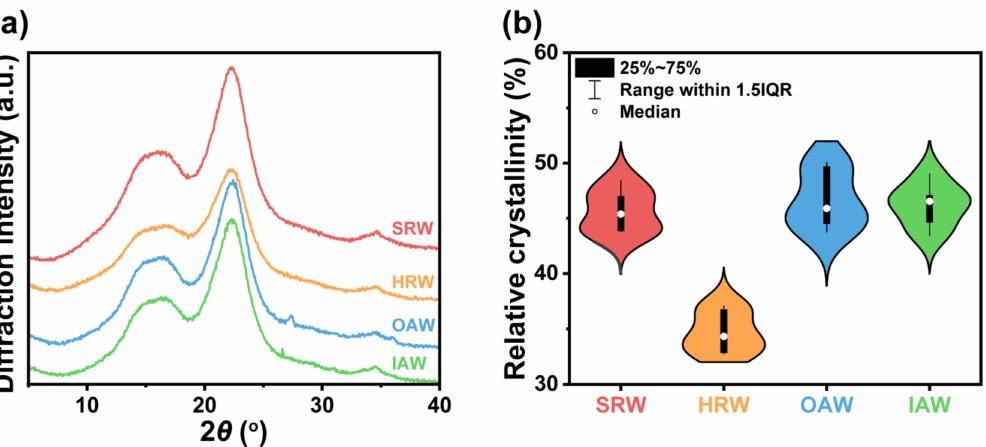
Figure 5. The cellulose crystalline structures of recent larch woods and ancient architectural woods. ( a ) X-ray diffractograms. ( b ) The relative